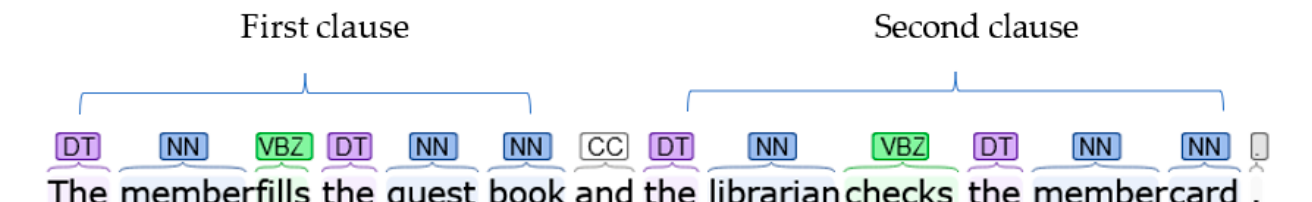
Figure 4. A compound sentence.